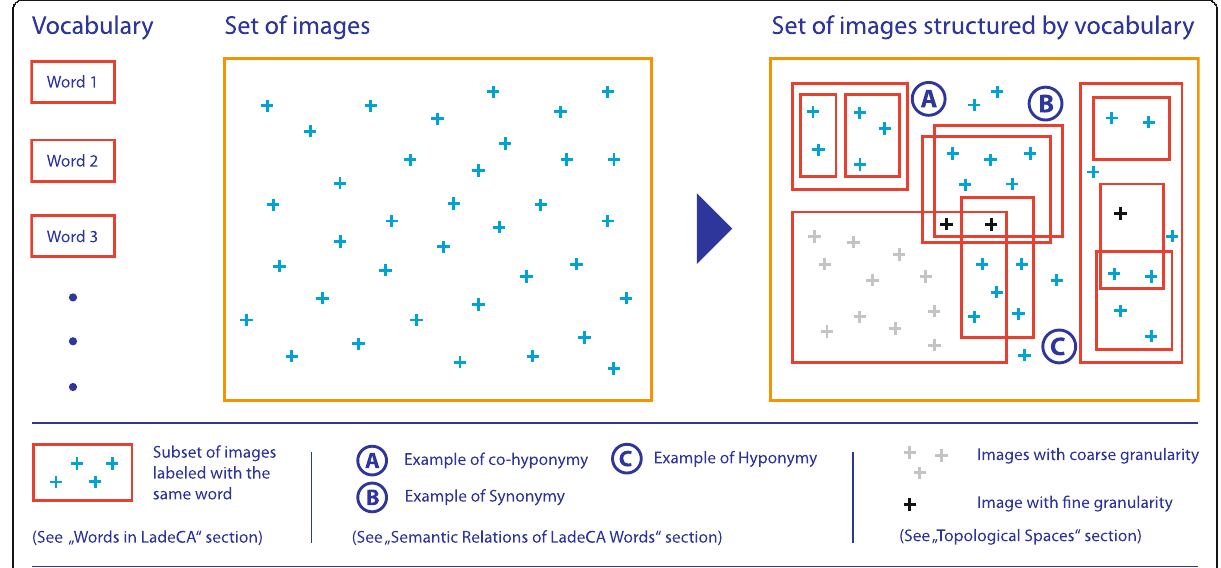
Fig. 2 Schematic representation of how a vocabulary structures a set of